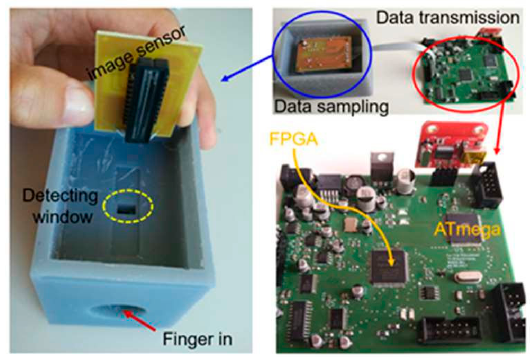
Figure 3. Integrated device comprising an LED, GMR color filter, and a CCD image sensor driven by a FPGA chip for biomedical inspection of human